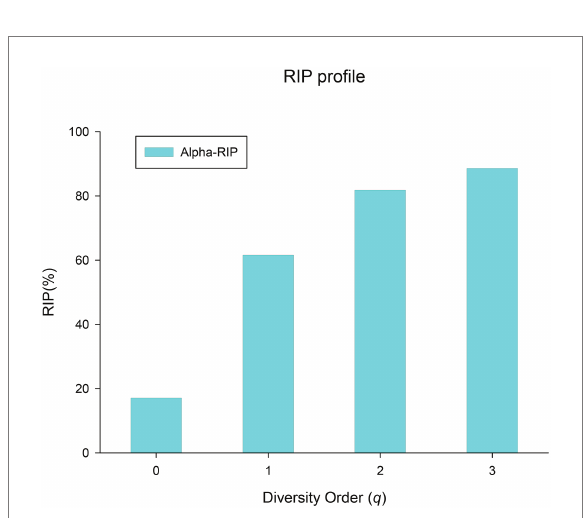
FIGURE 5 The RIP profile (RIP-q) of the human breast milk microbiome in healthy